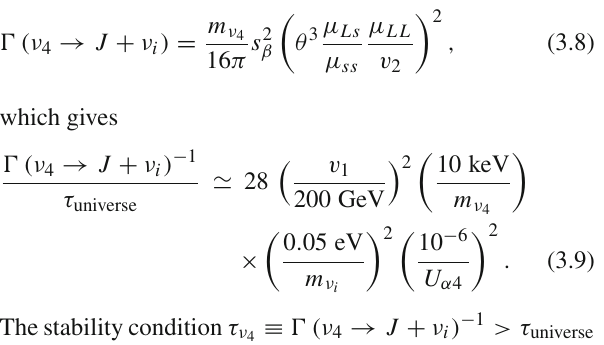
Fig. 1 Available parameter space allowing to reproduce the correct DM relic abundance for θ = 10 − 2 , 10 − 3 . The y-axis is the mixing angle between the dark matter mass eigenstate and the SM neutrino flavour eigenstates and the x-axis the dark matter mass. Black dashed lines represents the correct relic density for a fixed ratio μ Rs /μ Ls . The three blue shaded regions dubbed “X-ray” represent respectively, from left to right, constraints from XMM-Newton [55], NuSTAR [30] and INTEGRAL [56] on spectral photon lines generated by decaying dark